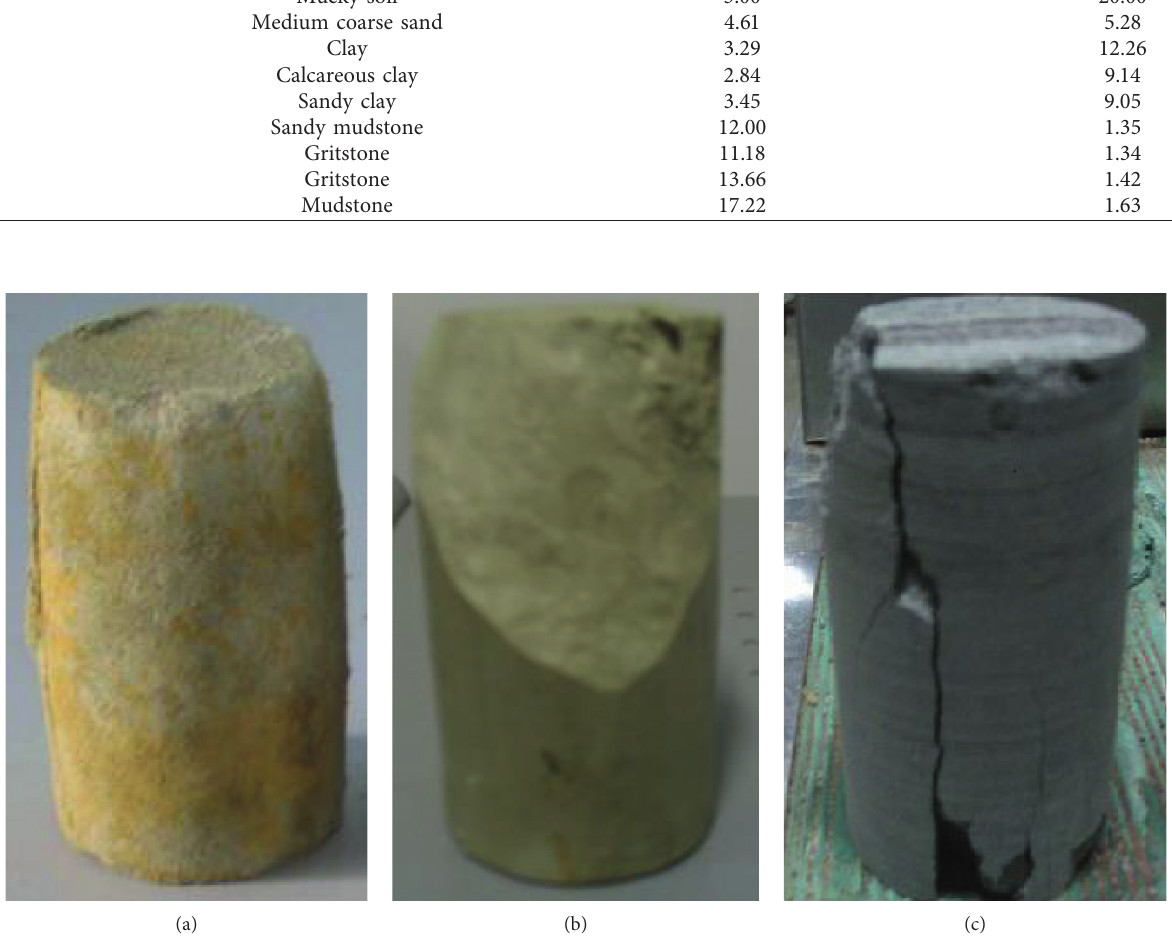
Figure 4: Rock and soil failure modes. (a) Compression failure. (b) Single inclined plane shear failure. (c) Splitting failure. Table 7: Comparison of average failure strains of samples for each group for different temperature